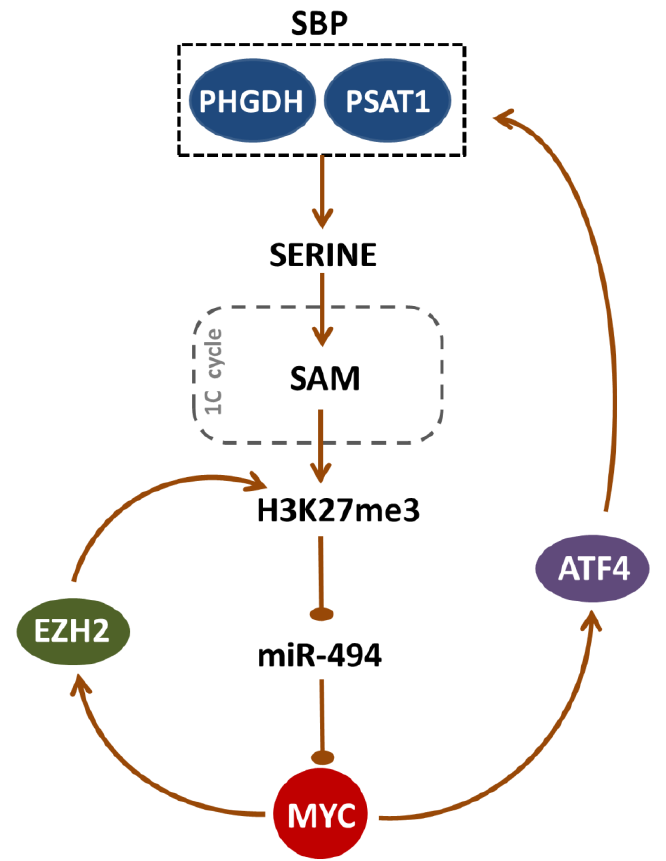
Figure 7. The reciprocal link between the serine biosynthesis pathway (SBP) and MYC oncogene. High PHGDH and PSAT1 activity leads to increased serine production, which fuels 1C metabolism, including folate and methionine cycles. One-carbon units from serine are utilized in the methionine cycle for the production of S-adenosylmethionine (SAM), which provides methyl groups for cellular methylation reactions, such as histone H3 trimethylation (H3K27me3). Increased H3K27me3 level is required to block miR-494 expression, which targets the transcription of MYC oncogene. MYC contributes to maintain high H3K27me3 level by indirectly regulating the expression of EZH2 methyltransferase and promoting the expression of SBP enzymes PHGHD and PSAT1 through ATF4 transcription factor. Sharp arrows: activation; blunt arrows: inhibition.